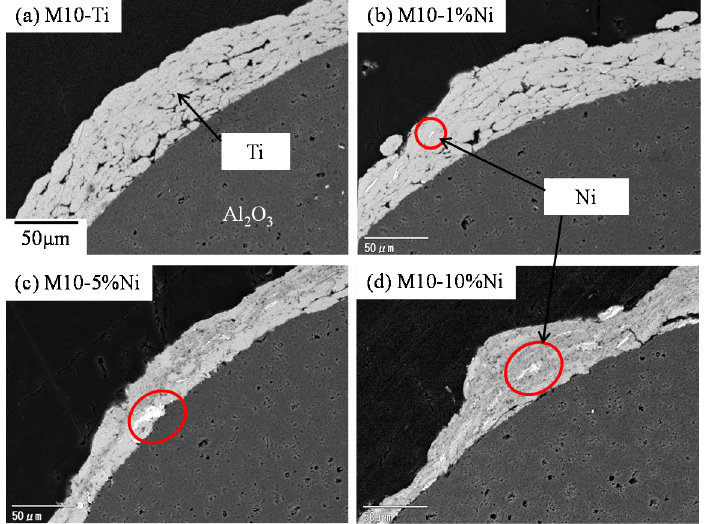
Figure 43. Cross-section SEM images of the M10- x Ni